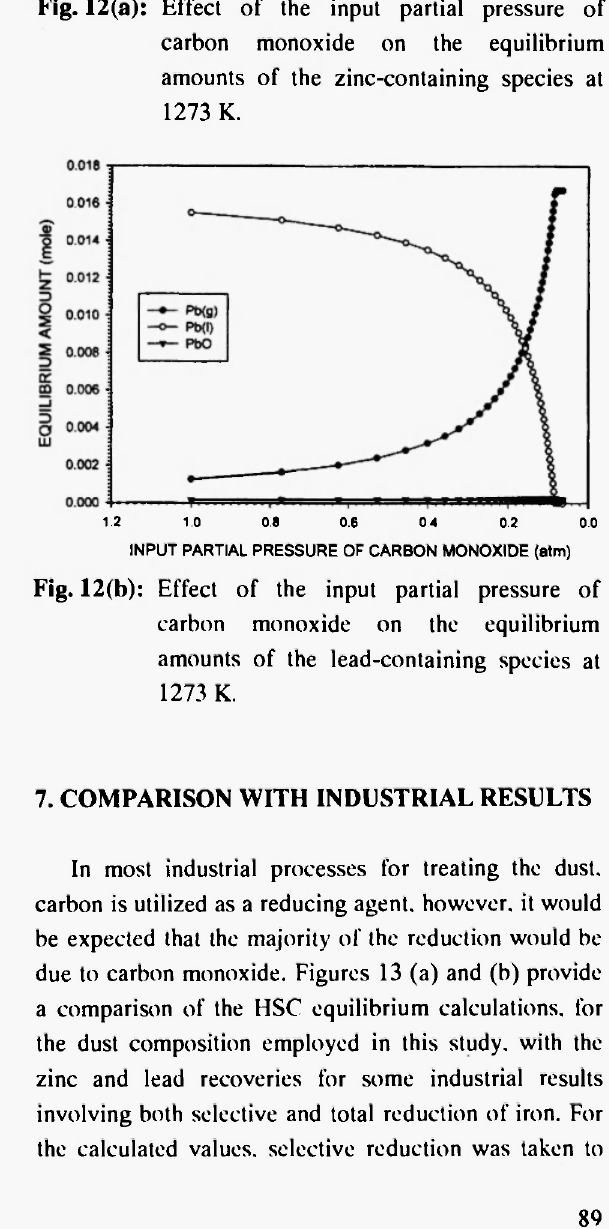
MAGNETITE CONTENT OF THE DUST (mass %) Fig. 11(d): Effect of the magnetite content of the dust on the zinc and lead recoveries for an input of one mole of carbon monoxide at 1573 K.